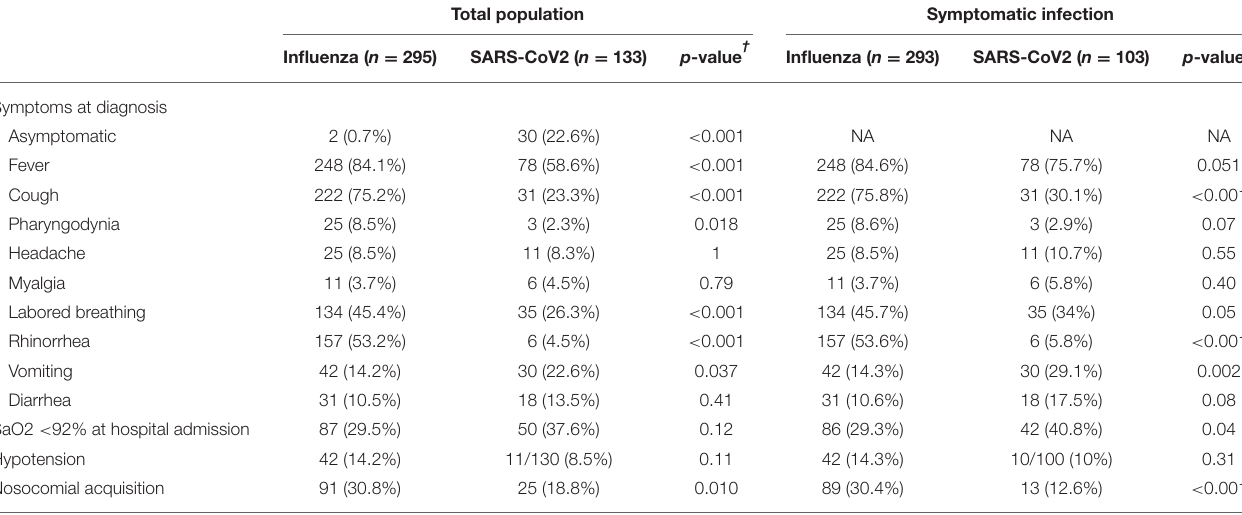
TABLE 2 | Clinical characteristics of patients with influenza and SARS-CoV2 infection.